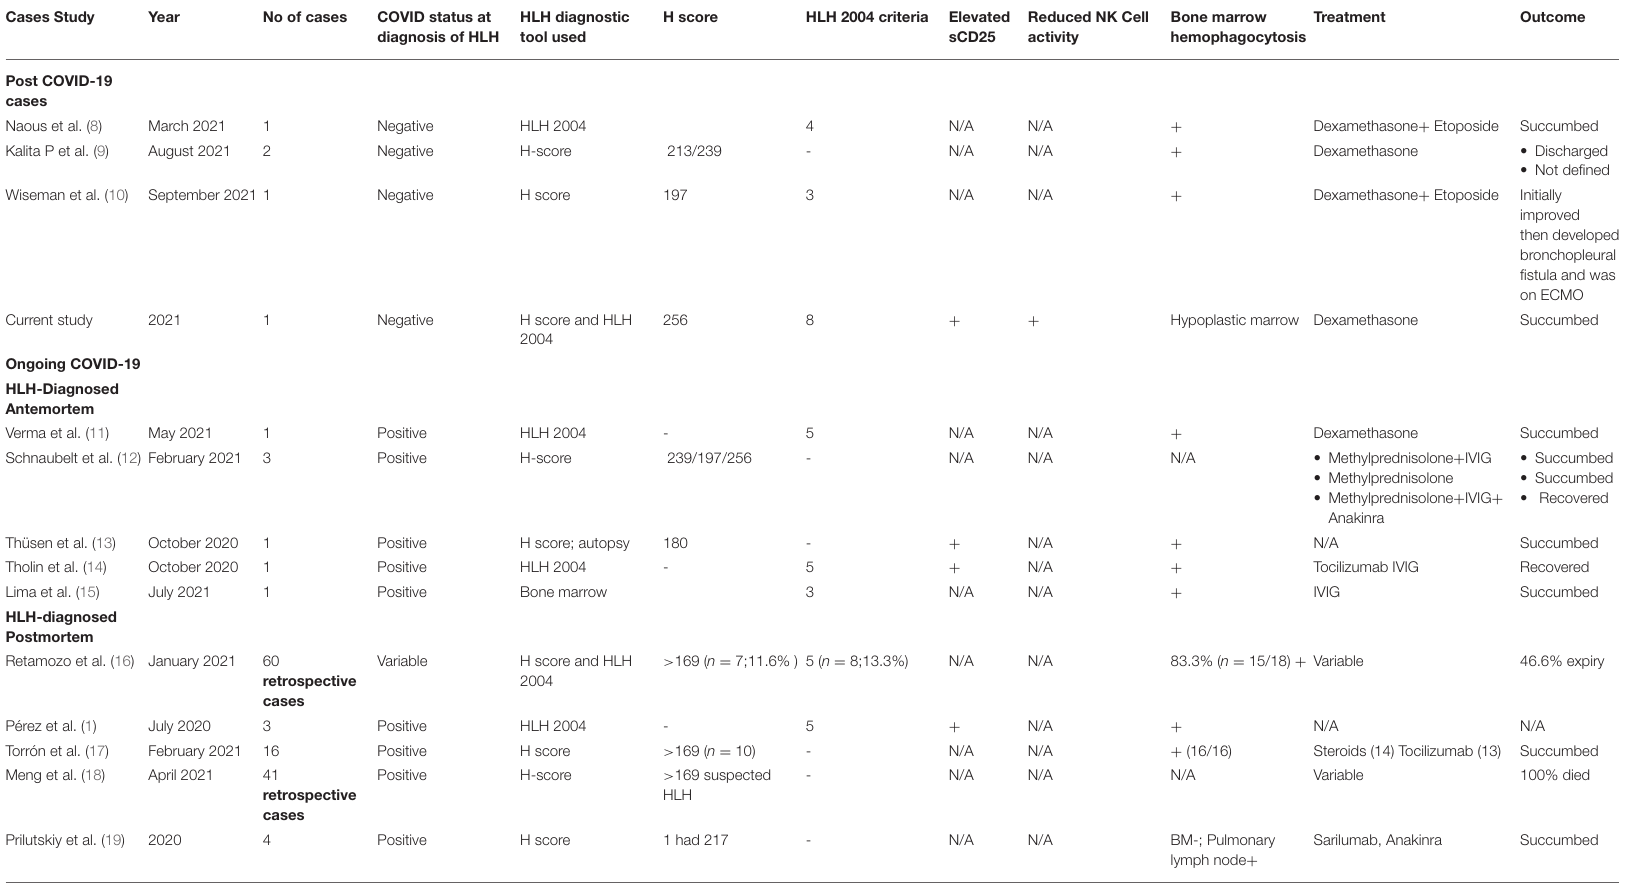
TABLE 2B | Tabulated comparison of studies on COVID-19-associated